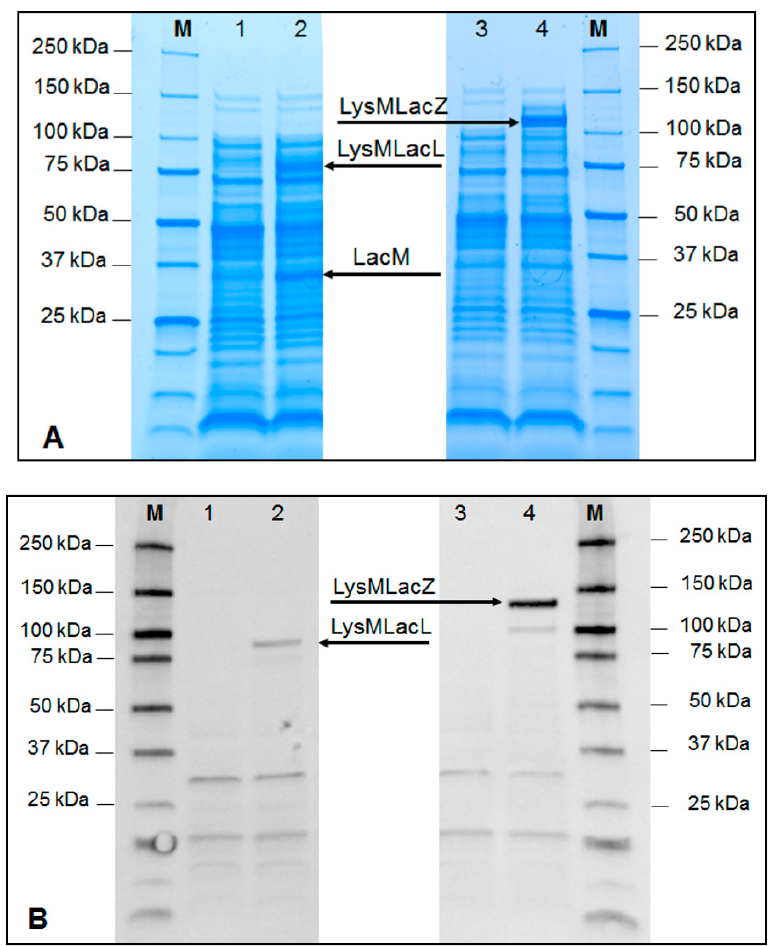
Figure 2. SDS-PAGE analysis ( A ) and Western blot analysis ( B ) of a cell-free extract of crude β -galactosidase fusion proteins, LysM-LacLMLreu (non-induced: lane 1, induced: lane 2) and LysM-LacZLbul (non-induced: lane 3, induced: lane 4), overexpressed in E. coli HST08. LacLMLreu encoded by two overlapping genes lacLM and LacZLbul encoded by lacZ gene are the β -galactosidases from L. reuteri and L. delbrueckii subsp. bulgaricus DSM 20081, respectively. The cultivation and induction conditions are as described in Materials and Methods and samples were taken at di ff erent time points after induction during cultivations. The arrows indicate the subunits of the recombinant β -galactosidases. M denotes the Precision protein ladder (Biorad, CA,